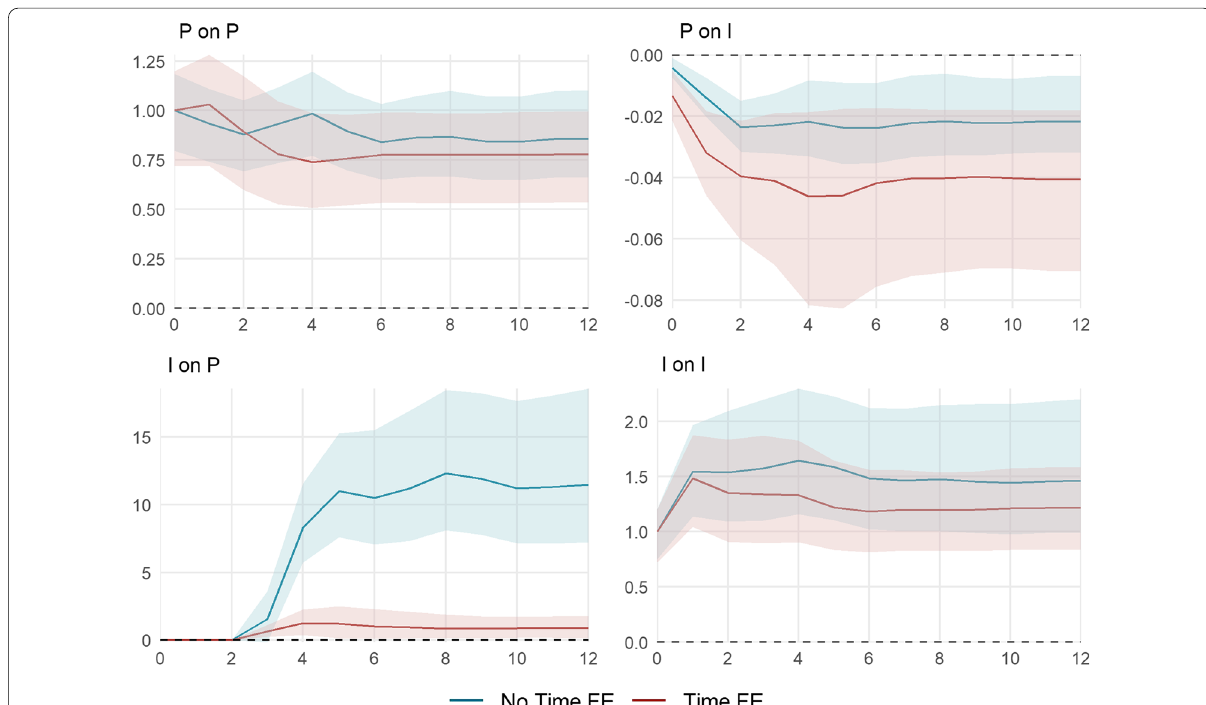
Fig. 10 Cumulative impulse responses of policy P and infection growth I . The impulse responses are estimated using the recursively ordered VAR(4) ln R e and with (red) and without (blue) time fixed effects. The data span September 28, 2020, until 3 and B omitted, P (cid:31) KSI + , I in (4) with k = = = April 18, 2021. The shaded areas represent the 95% confidence intervals based on a wild bootstrap procedure with 5000 repetitions. The horizontal axes depict the time horizon in weeks. The vertical axes show the level response of the KSI + (left) and lnNINF